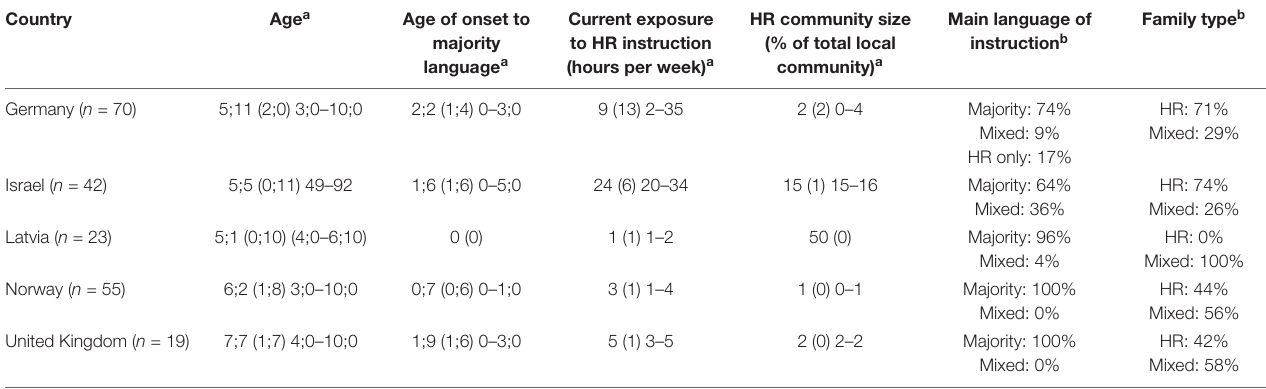
TABLE 2 | Background information on the participants per country.